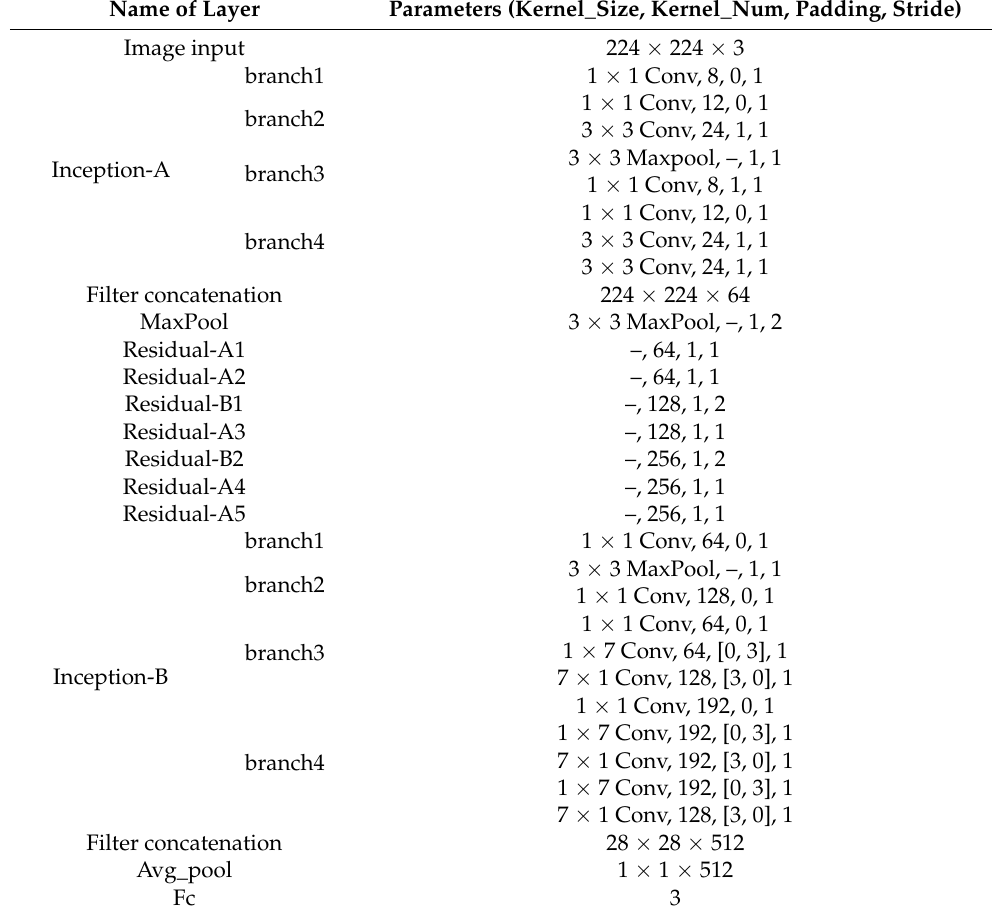
Table 1. Parameters of the IRBOA model